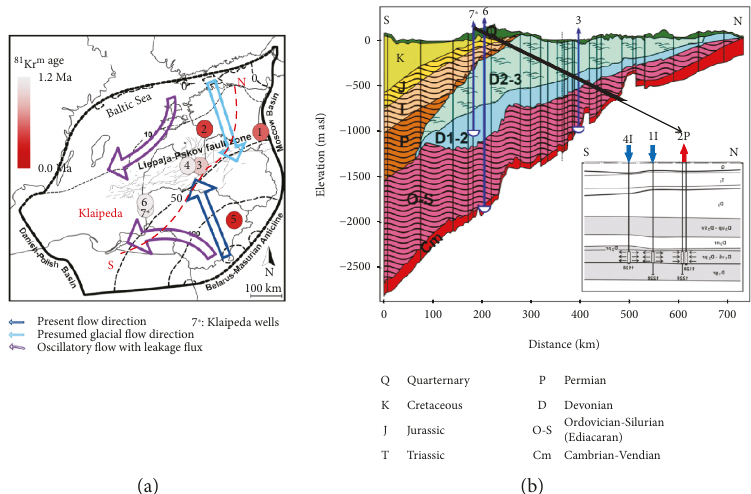
Figure 3: (a) Groundwater fl ow direction and age in the Baltic Sea area after Gerber et al. [18]. (b) Geological cross section and well location of the Klaipeda site, modi fi ed after Gerber et al. [18] and Zinevicius et al.